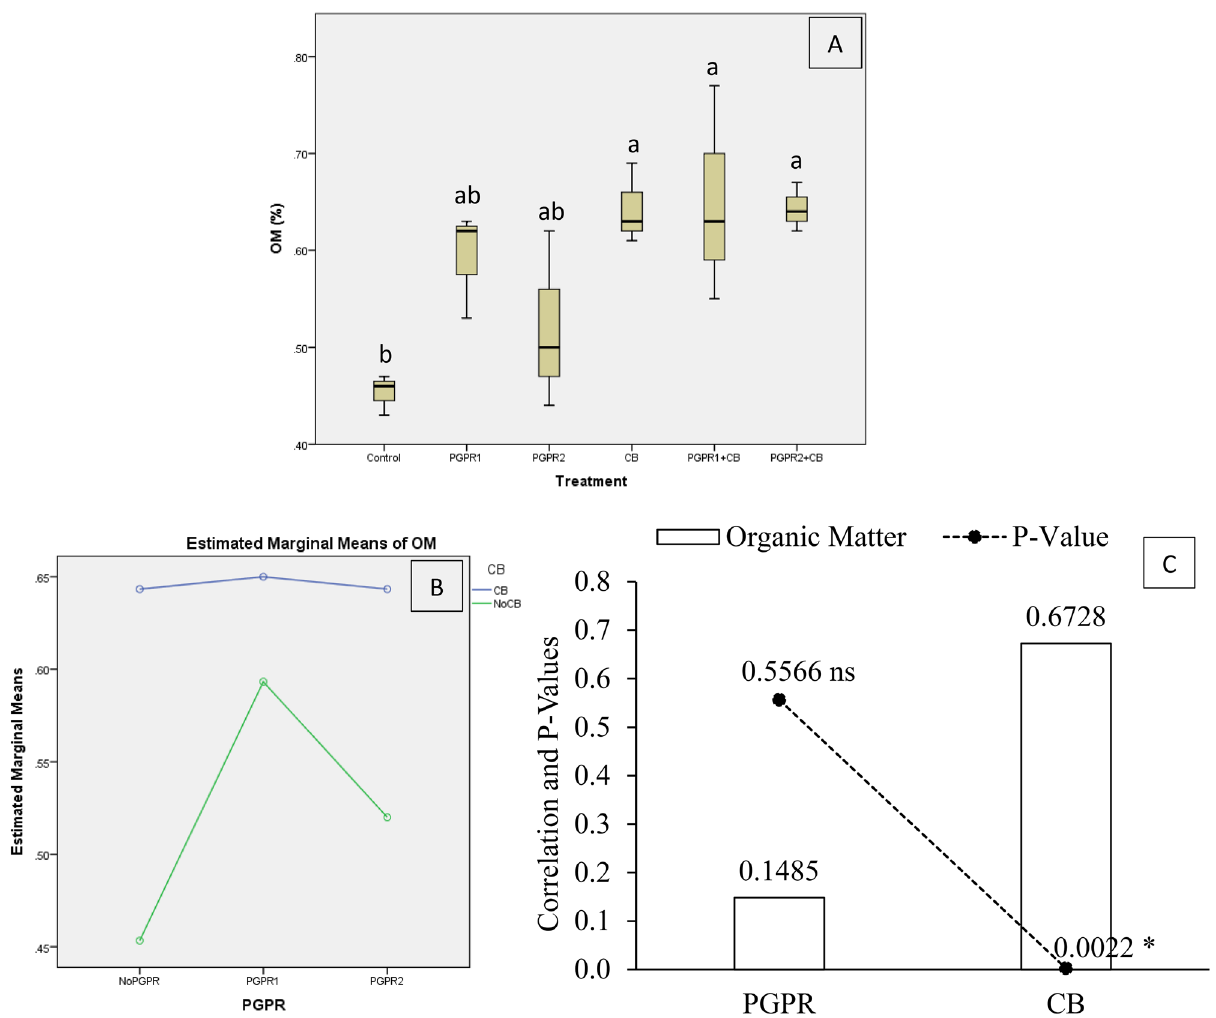
Figure 3. Effect of treatments on the organic matter of the soil. Values are the average of three replicates ( A ). Different letters showed significant differences (Tukey’s test; p ≤ 0.05). Interaction graph of PGPR and CB for soil OM ( B ). Correlation graph of PGPR and CB for soil OM ( C